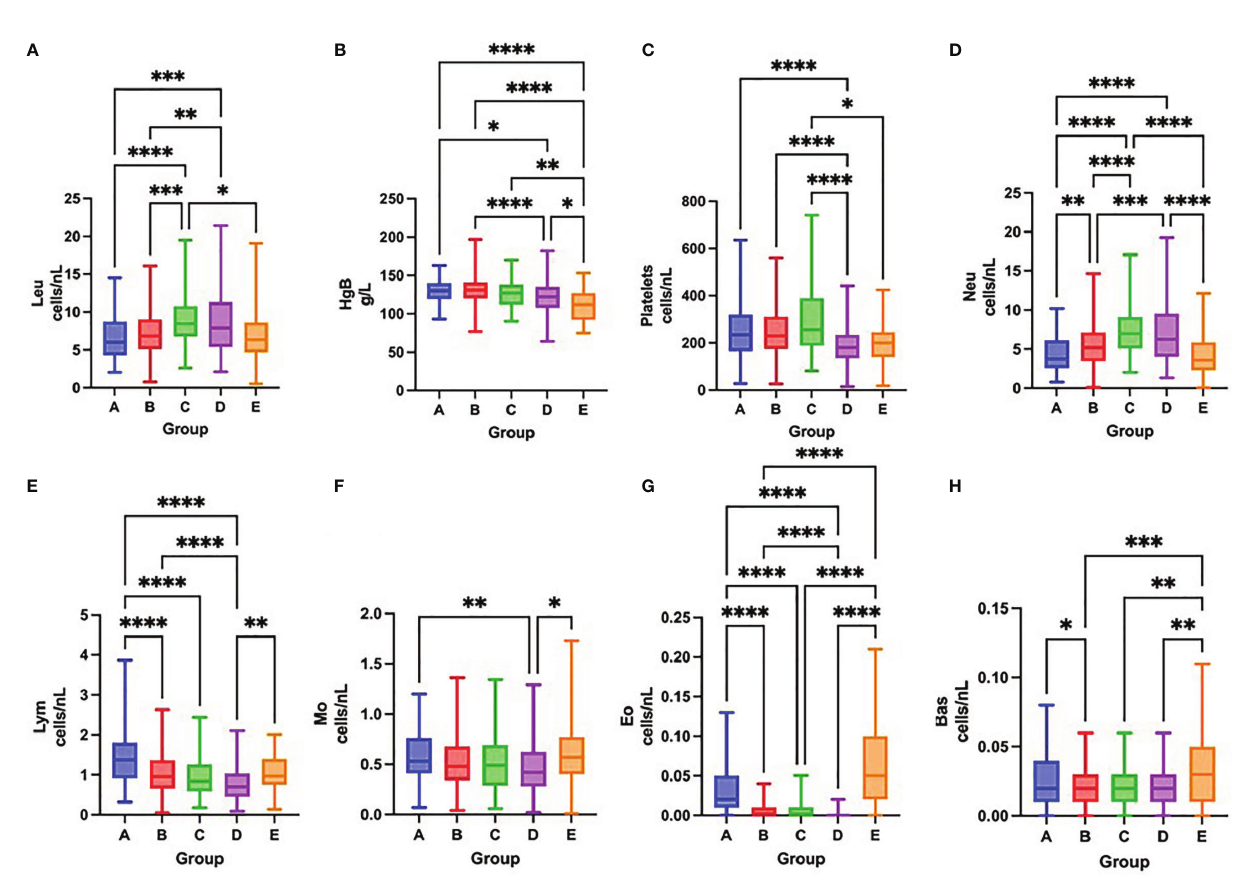
FIGURE 3 | Differences in the total number of leukocytes (A) , concentration of hemoglobin (B) , total number of platelets (C) , neutrophils (D) , lymphocytes (E) , monocytes (F) , eosinophils (G) and basophils (H) among groups A – E on admission to the hospital, Kruskal-Wallis test. *p < 0.05; **p < 0.01; ***p < 0.001; ****p <